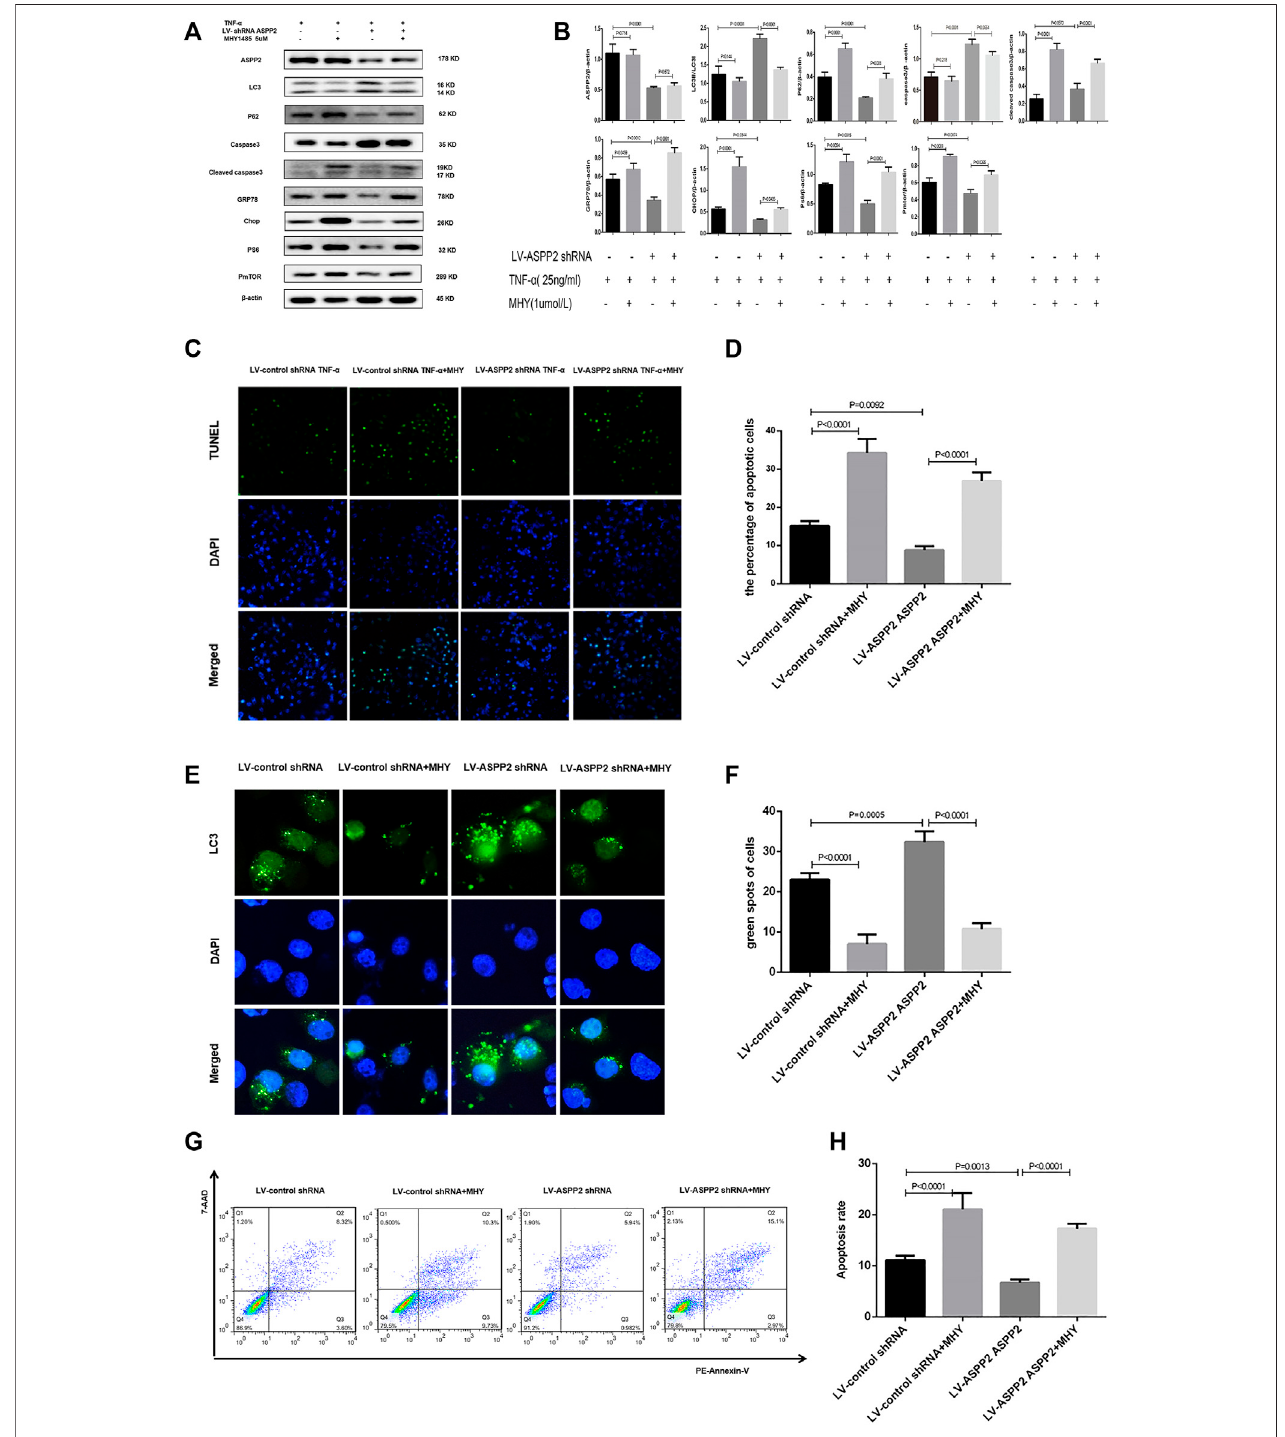
FIGURE 6 | ASPP2 inhibited autophagy but promoted ERS-apoptosis through mTORC1 pathway in the hepatocyte injury induce by TNF- α . HL7702 cells were integrated into stable cell lines using LV-ASPP2shRNA or LV-control shRNA. The stable cell lines were treated with MHYI485 (5 umo/L) and then induced by TNF- α (25 ng/ml)for24 h. (A,B) RepresentativewesternblottinganalysiswasconductedofproteinexpressioninHL7702cellsaftertreatment.Quanti fi cationswerenormalized to β -actin and expressed as relative density. (C,D) Representative apoptosis images were presented by TUNEL assay. The number of apoptotic cells were calculatedusingImageJsoftware. (E,F) AGFP-LC3plasmidwastransfectedintocellsandtherepresentative fl uorescenceimageofcellswereshowed.Thegreenspots of cells were manually quanti fi ed in fi ve randomly selected areas. (G,H) Representative apoptosis images were showed with PE and 7-AAD reagents by fl ow cytometry. The apoptosis rate was calculated using the proportion of early and late apoptotic cells in total cells.